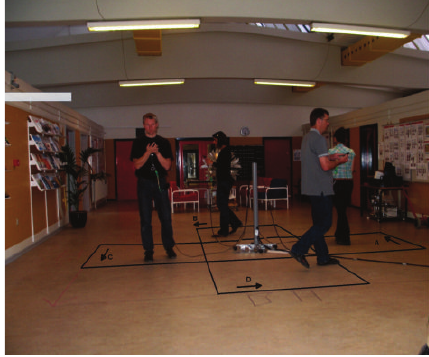
Figure 3: Investigated scenario.